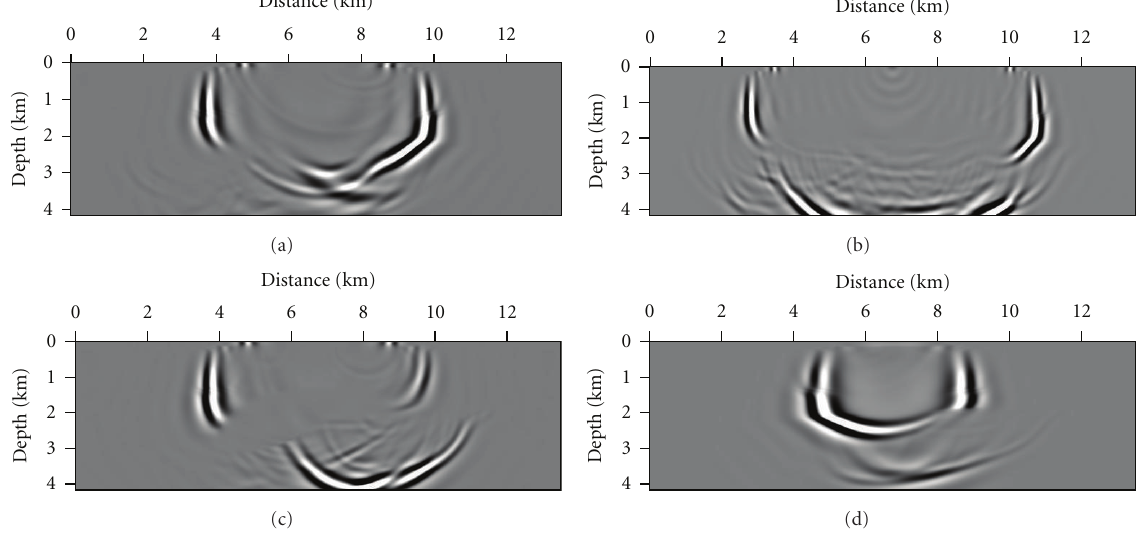
Figure 9: Impulse response of FFDPI migration with two-way splitting using 10 reference velocities. Vertical cuts as in Figure 3.